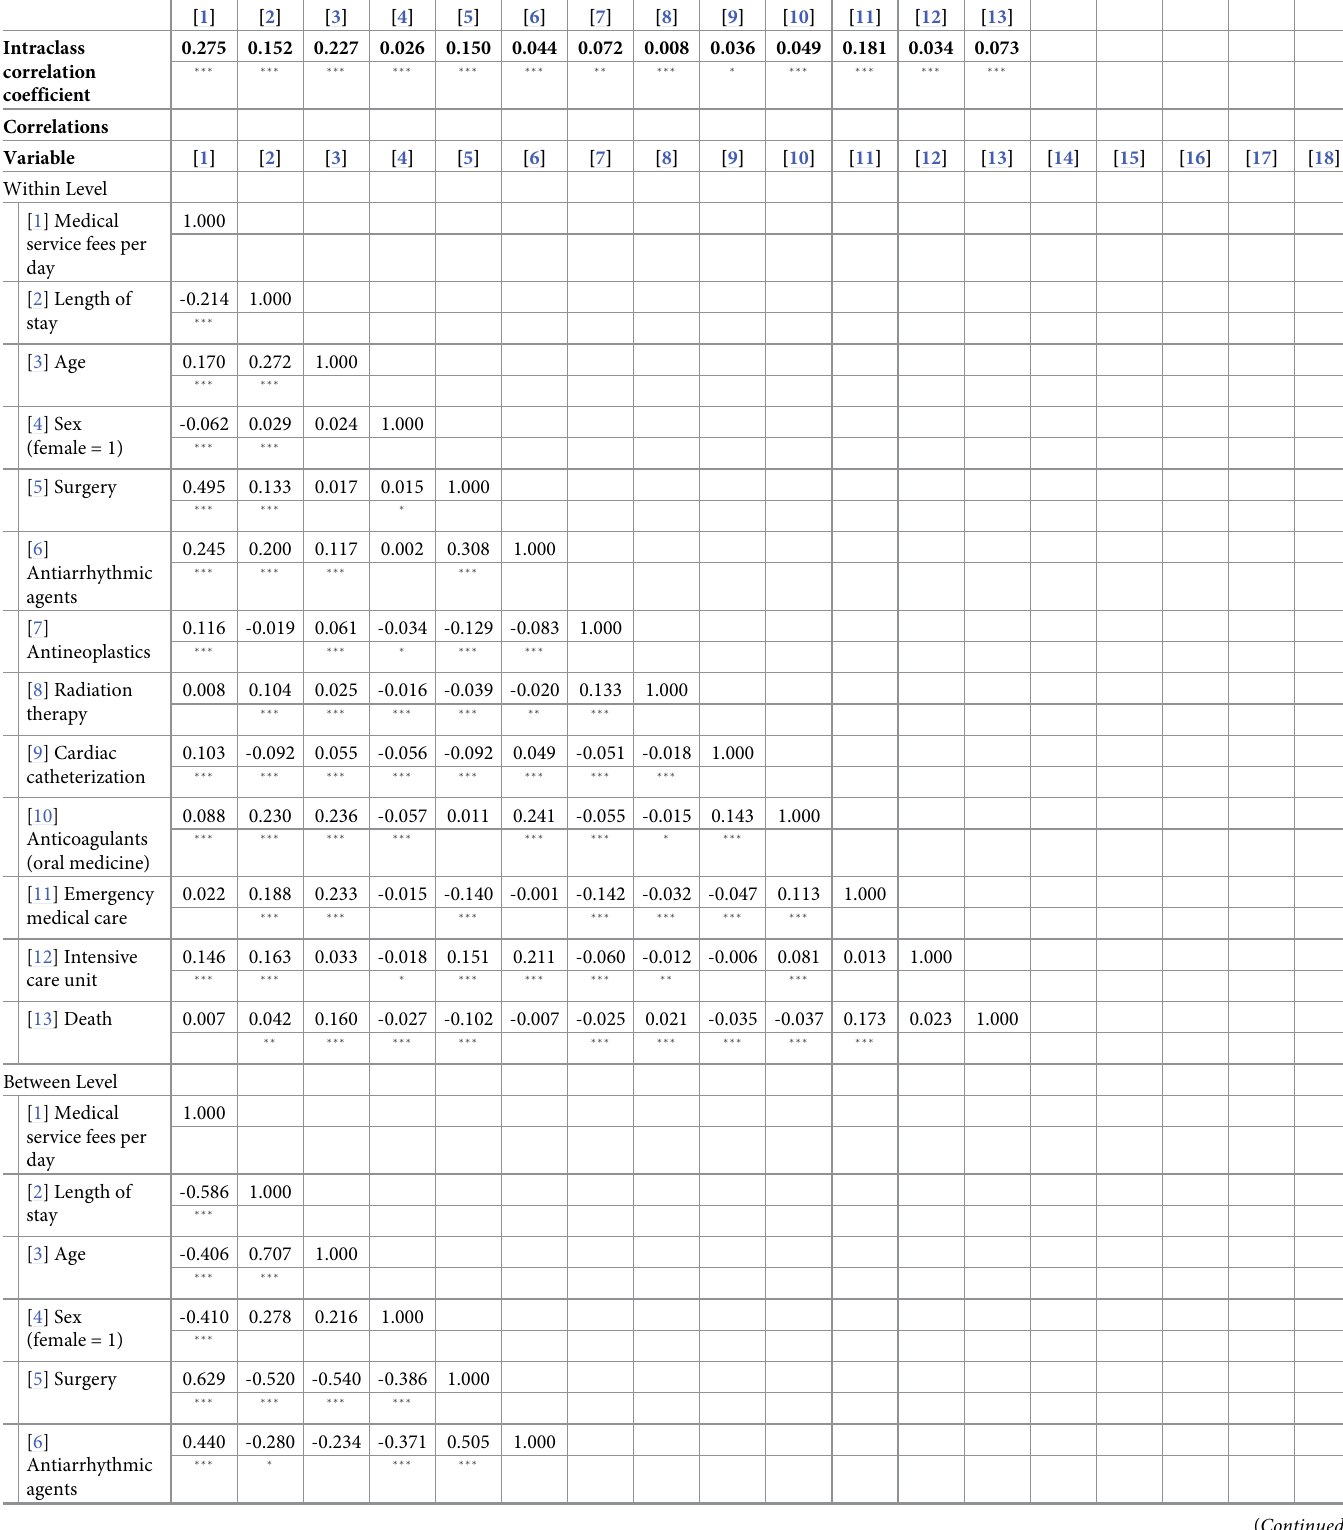
Table 2. Correlations for the within and between